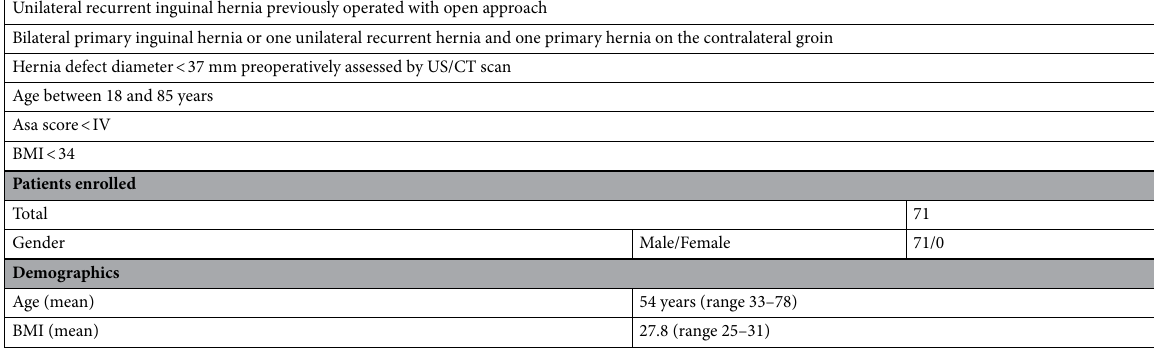
Table 1. Inclusion criteria and patient demographics.